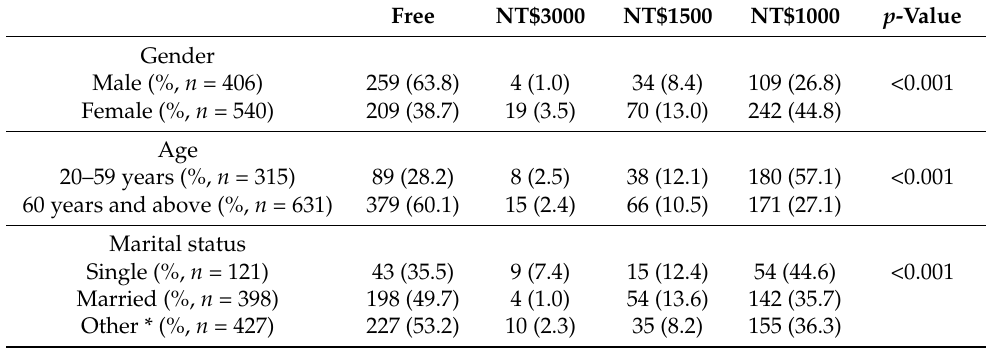
Table 5. The cost of advance care planning participants in Taipei Veterans General Hospital in